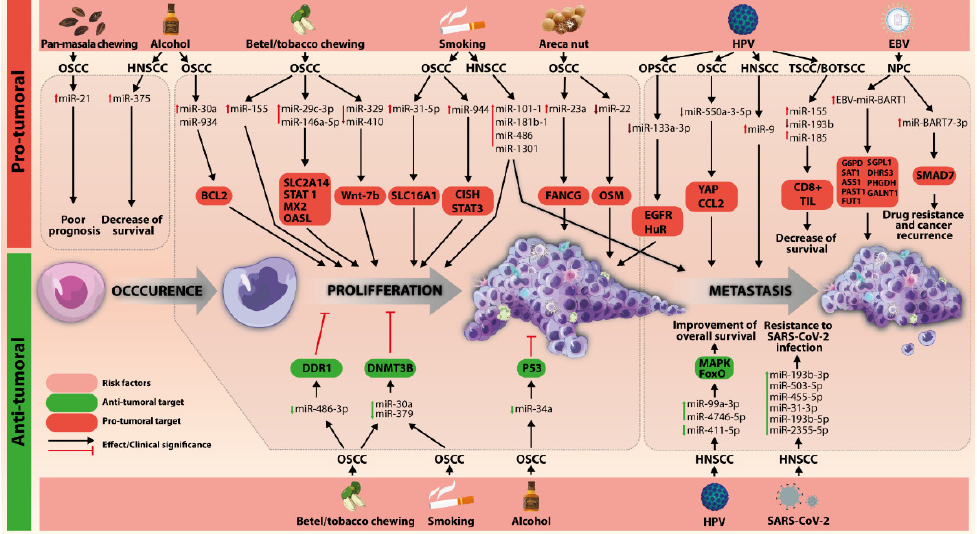
Figure 2. The connection between miRNAs and the main risk factors in oral cancer.